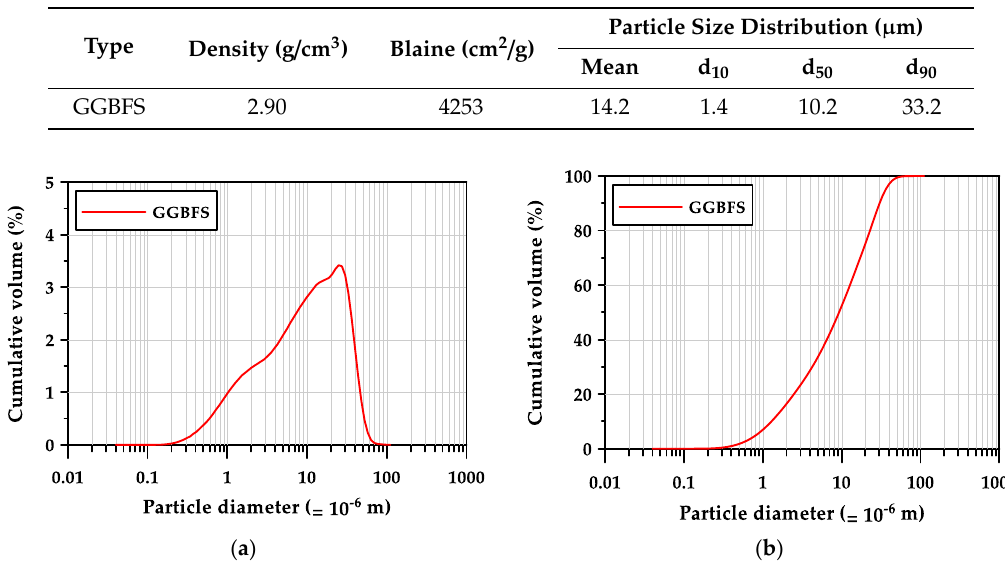
Figure 1. Particle size characteristics of GGBFS: ( a ) particle size distribution, ( b ) cumulative particle size distribution.